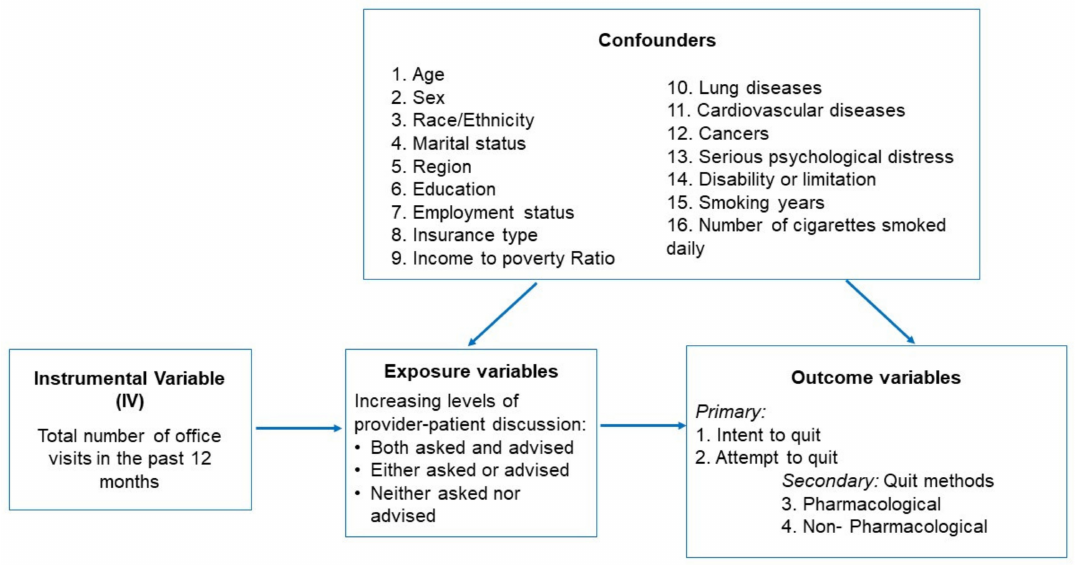
Figure 1. A graphic representation of the instrumental variable (IV)